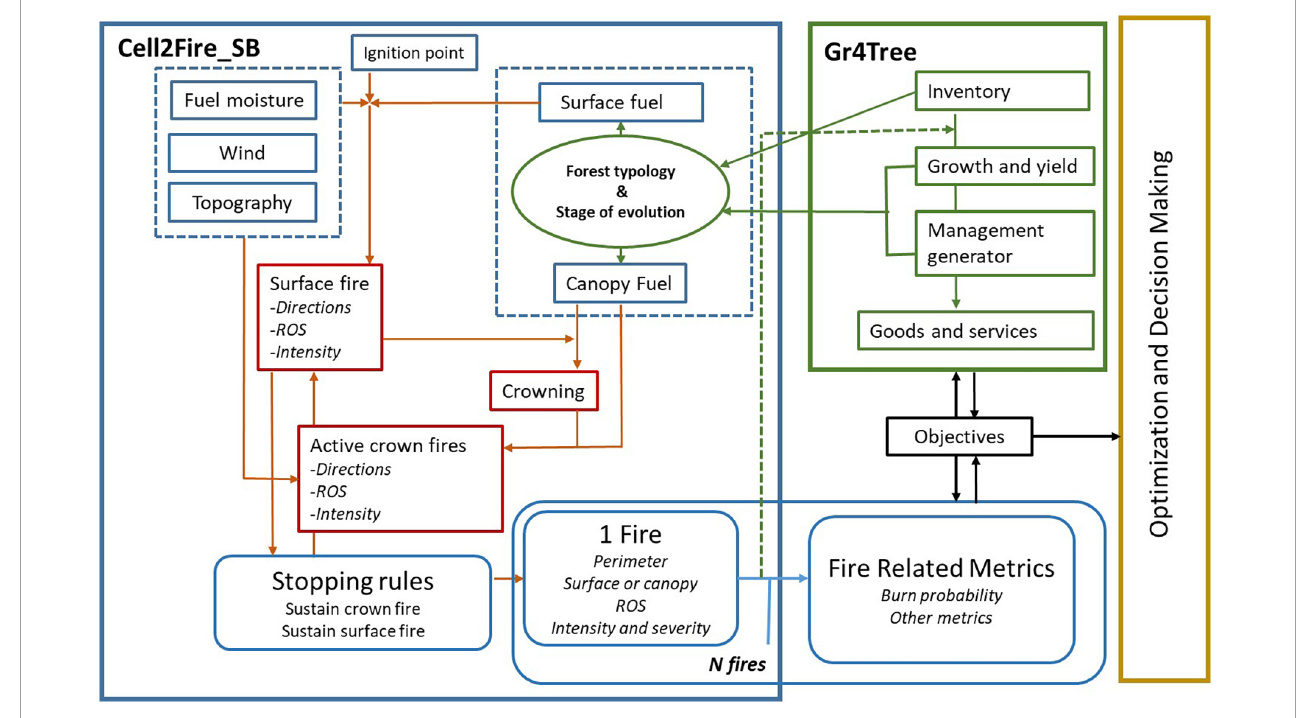
FIGURE1 Conceptual idea for a DSS to solve landscape level tactical planning problems, integrating the fire growth and mapping system (Cell2Fire_SB), the forest growth and management simulator (Growth4tree) and an optimization/planning solver.